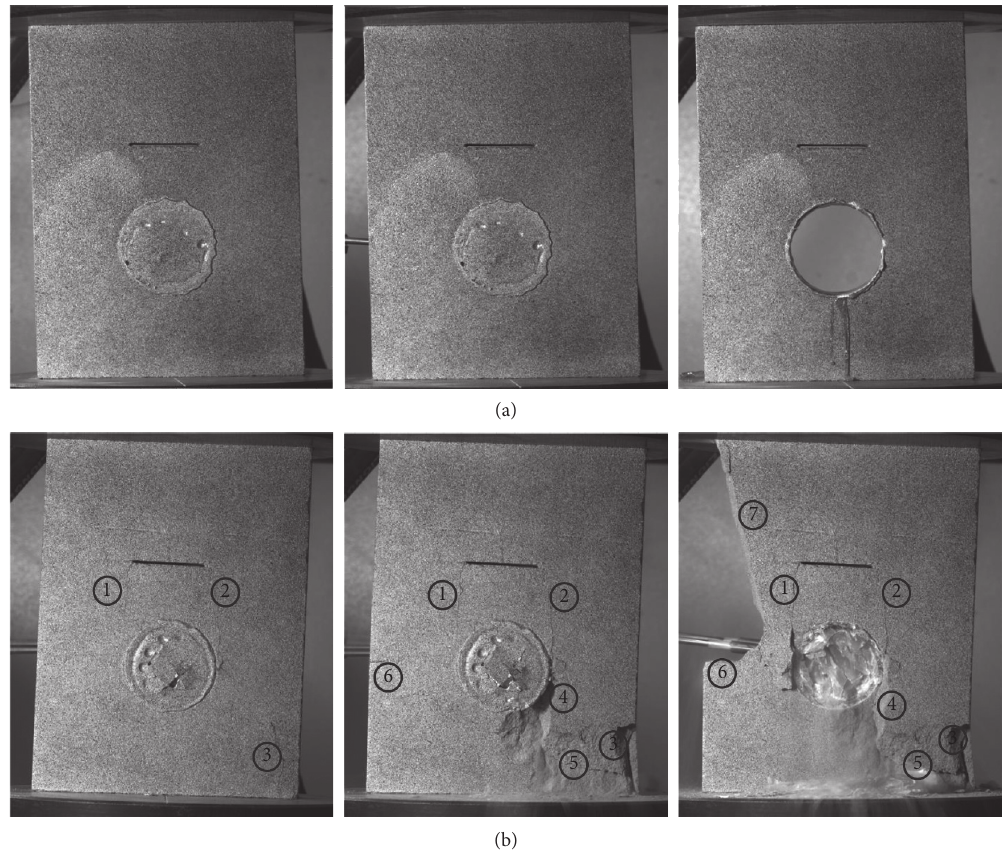
Figure 4: Crack evolution process of α � 0 ° : (a) S-0-80; (b)